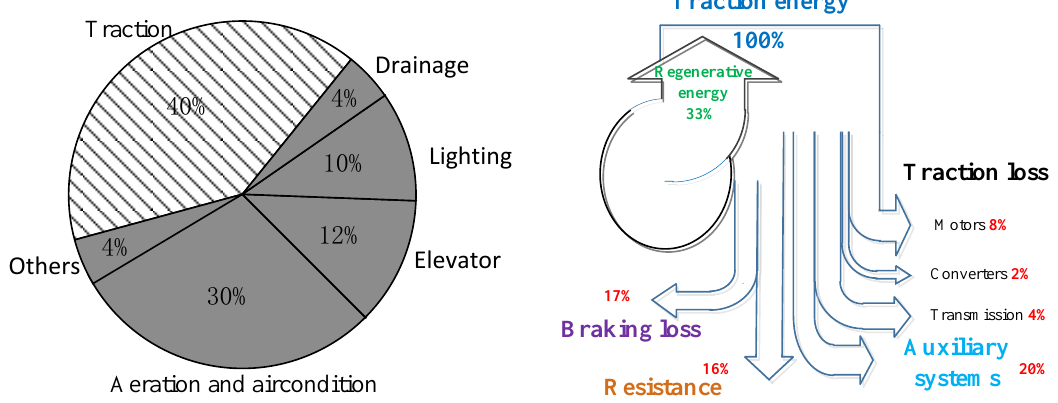
Figure 1. Energy consumption in metro